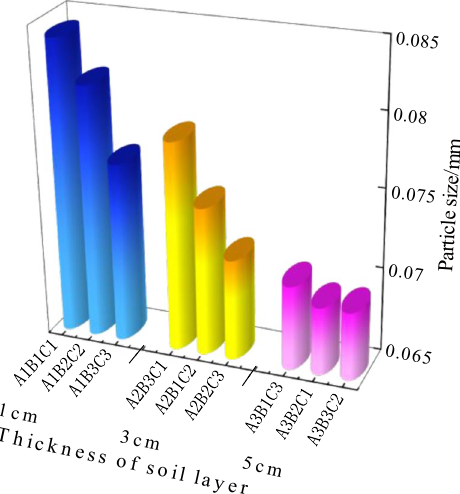
Figure 17. Graph of particle size versus soil